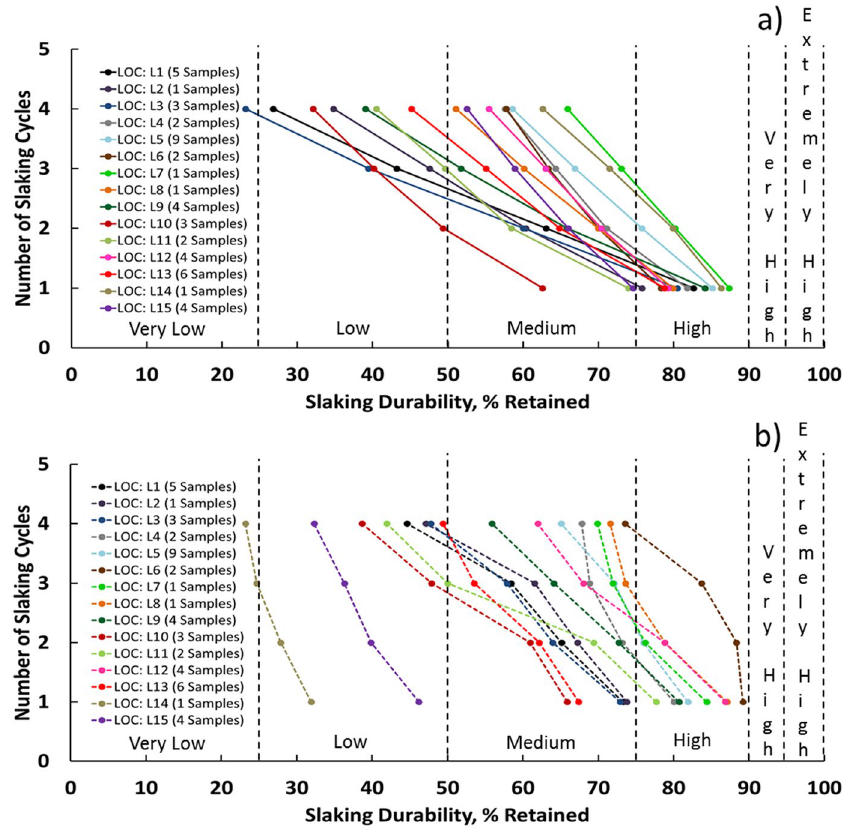
Figure 12. The relationship between number of slaking cycles and slaking durability, % retained for samples collected from 15 locations and slaked with ( a ) distilled water and ( b ) groundwater including SDI Classification 1